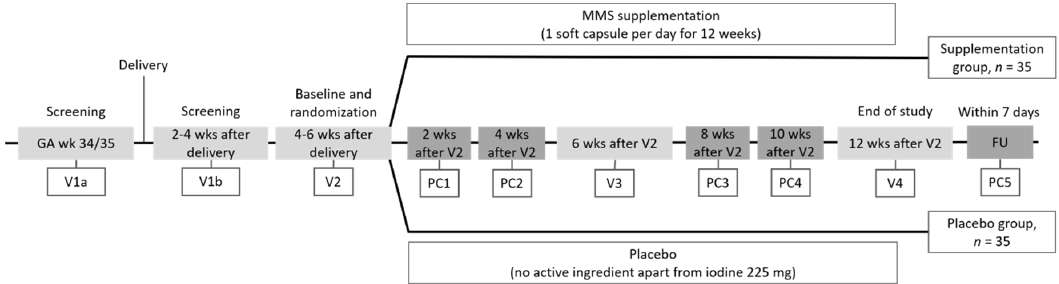
Figure 1. Study design. V1a, first screening; V1b, second screening; V2, randomization and